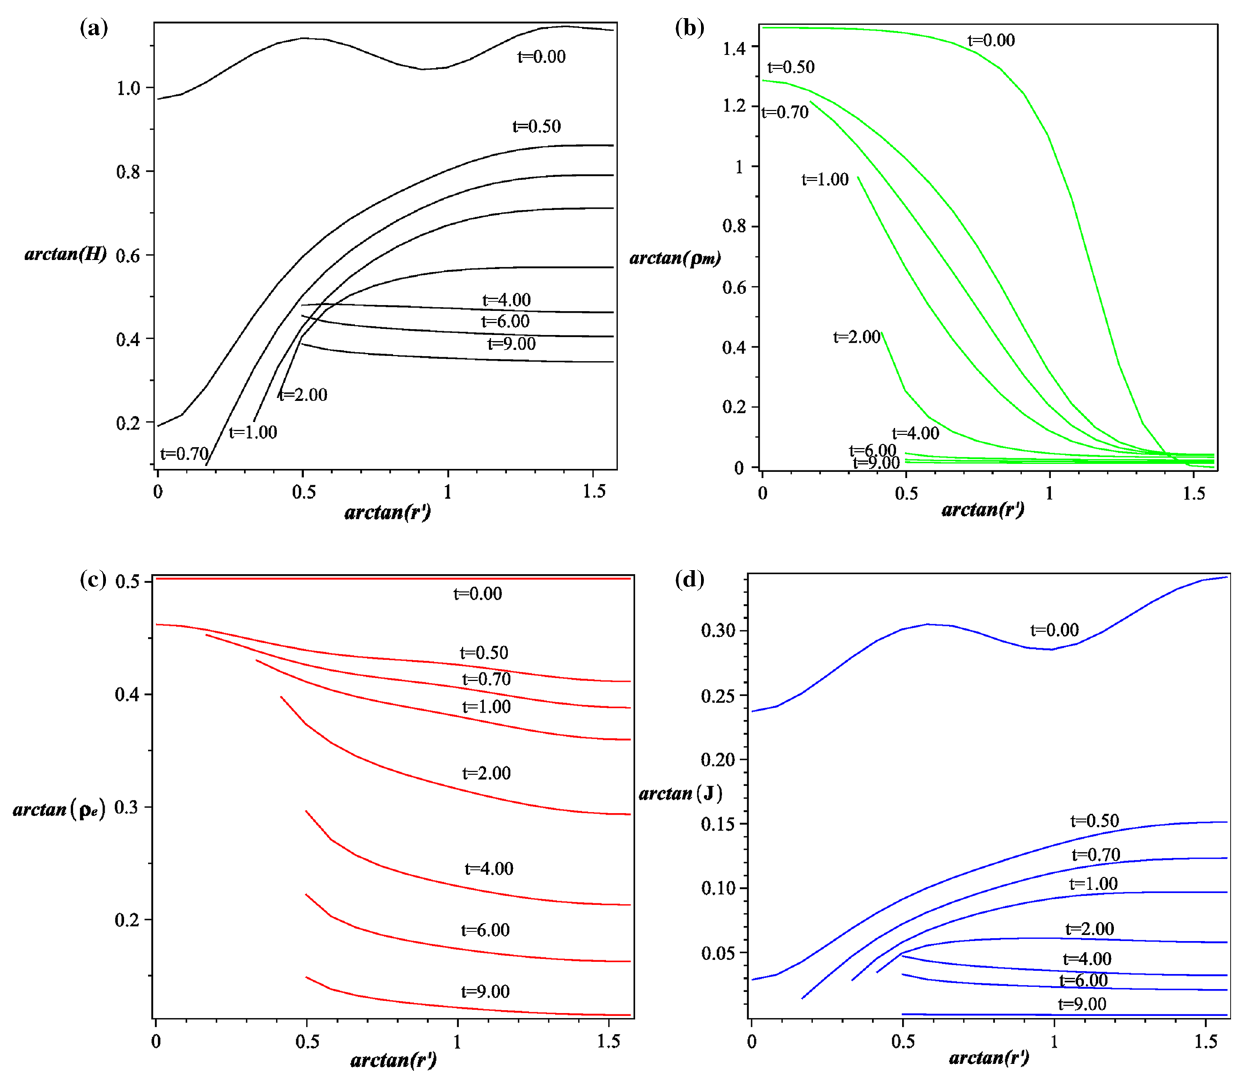
Fig. 4 Local profiles of different scalar functions for the configuration with initial conditions given by (31) and w = − 1 . 0, α = 0 . 1 at different instants of time. a local scalar H . b local scalar ρ ( m ) . c local scalar ρ ( e ) . d scalar J . Refer to the text for a detailed discussion of the